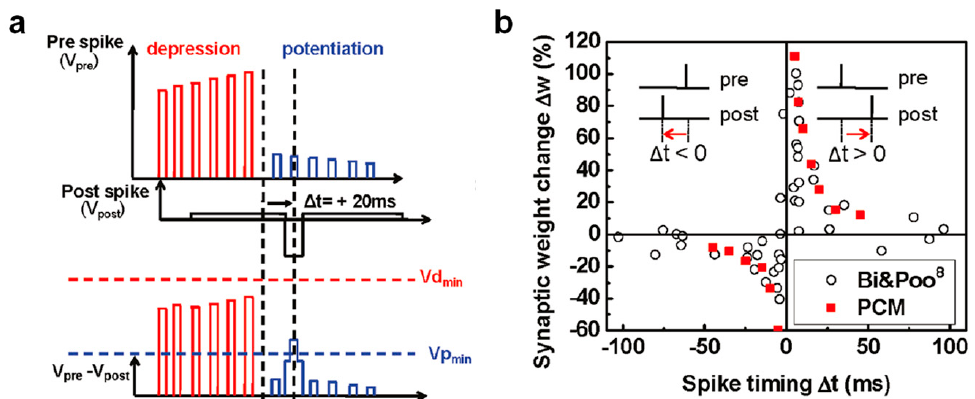
Figure 14. ( a ) PRE and POST spike waveforms applied at terminals of a PCM ‐ based synaptic device to change its weight via an overlap ‐ based STDP scheme. The application of a positive time delay of 20 ms leads to a conductance increase (potentiation) in the PCM synapse since the spike overlap leads the effective voltage across the PCM to cross the potentiation threshold whereas the higher depression threshold is not hit. ( b ) Measured weight change as a function of the spike timing achieved using a PCM synapse against experimental data collected by Bi and Poo in biological synapses. Reprinted with permission from [144]. Copyright 2012, American Chemical